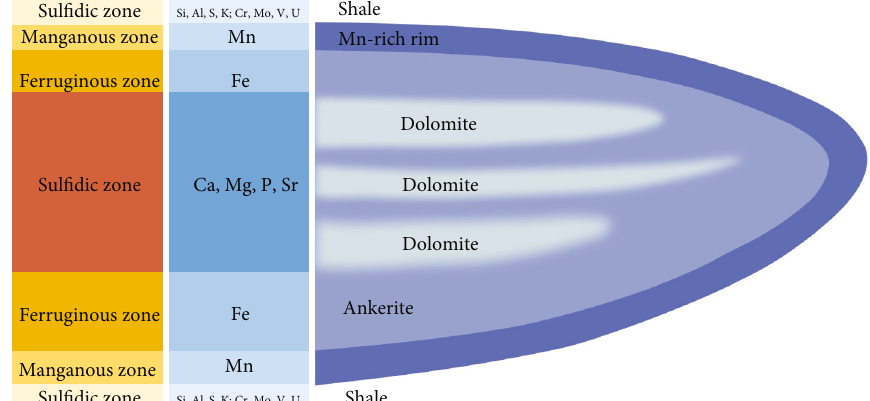
Figure 15: Schematic diagram of dolomite nodule embedded in shale with the corresponding enriched elements and redox zones in strati fi ed water